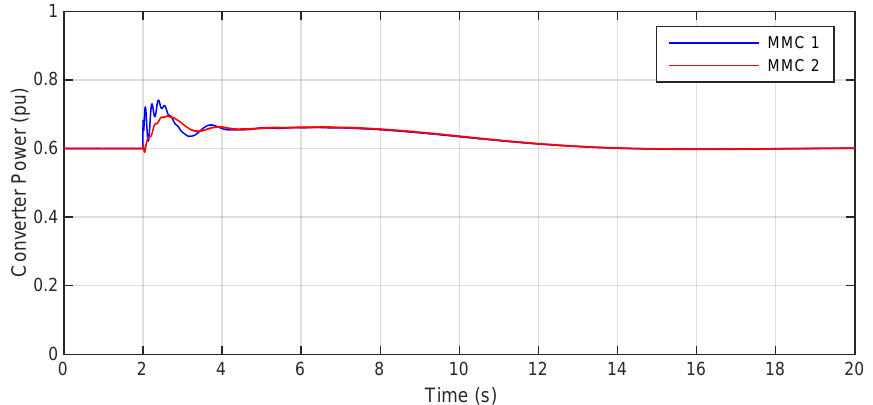
Figure 12. Frequency of the voltage generated at the HVDC converter terminals after the disturbance in Scenario 2.